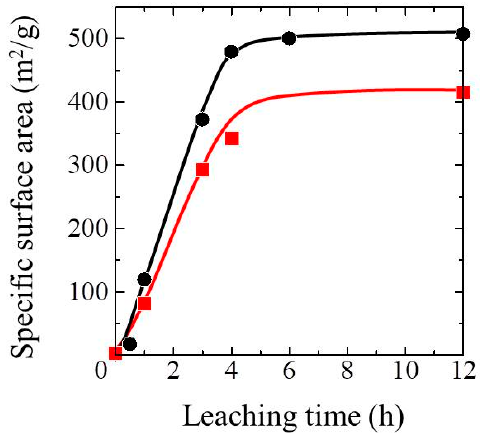
Figure 6. Specific surface area versus leaching time of the TiO 2 -coated porous glass cloths (squares) and the uncoated porous glass cloth (circles).